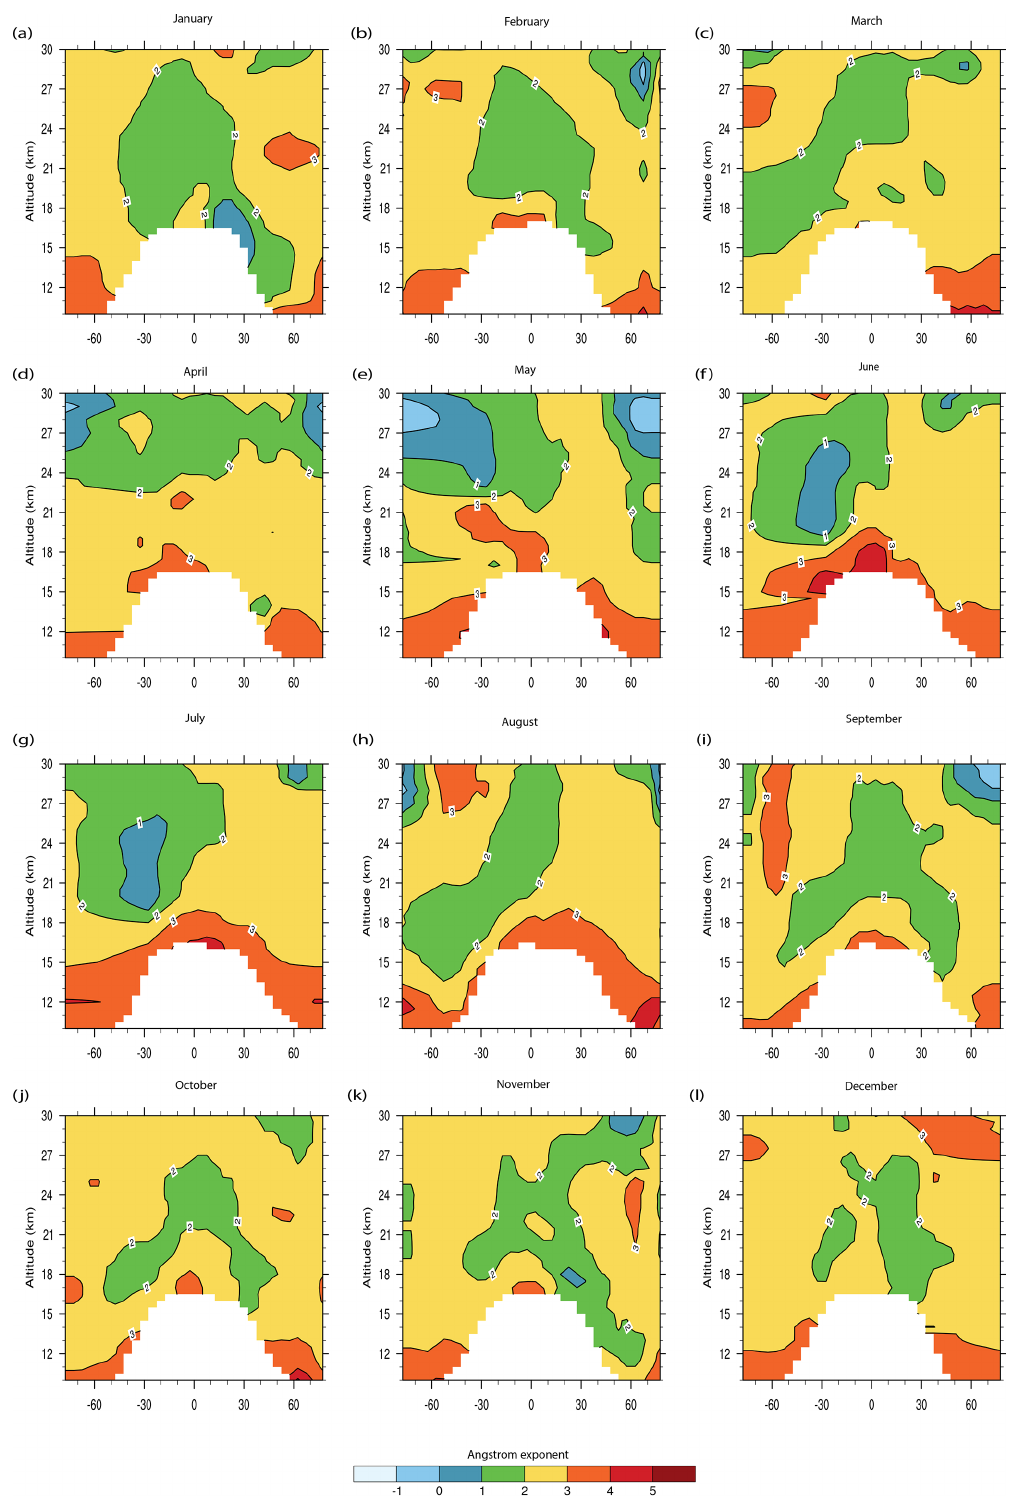
Figure 11. Altitude versus latitude of the pseudo Ångström exponent monthly climatology derived using OSIRIS 750nm extinction and SAGE II and SAGE III/ISS 1020nm extinction. A 3 × 3 median smoothing is used to remove any outliers and is then linearly interpolated to fill in any missing